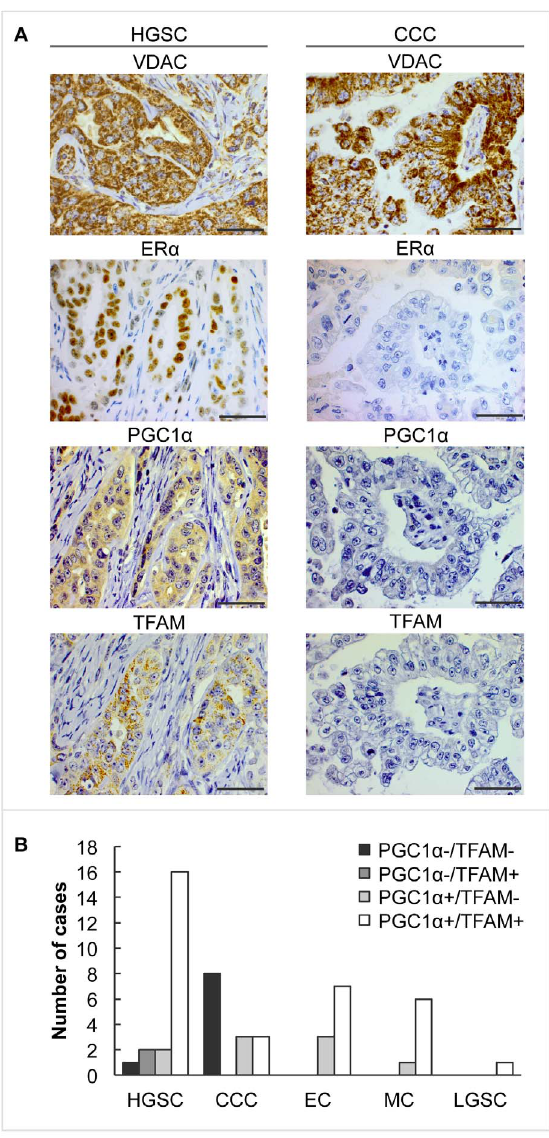
Figure 3. Expression of PGC1 a and TFAM in EOC subtypes. (A) Representative immunohistochemical staining of VDAC, ER a , PGC1 a and TFAM in HGSC and CCC. VDAC indicates presence of mitochondria. ER a , PGC1 a and TFAM were all expressed in HGSC, whereas in CCC expression of the proteins was lost. Each HGSC and CCC quadruplicate is from one and the same patient (magnification: 400x, scale bar shows 500 m m). (B) Histogram representing number of cases with expression of PGC1 a /TFAM across EOC subtypes.